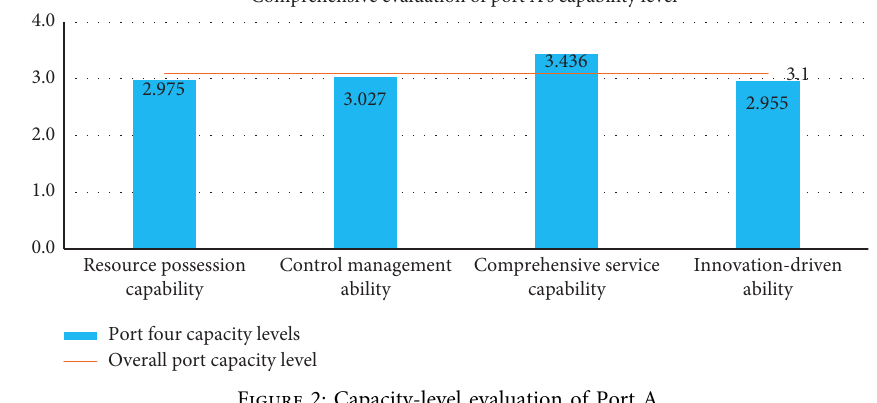
Figure 2: Capacity-level evaluation of Port A.